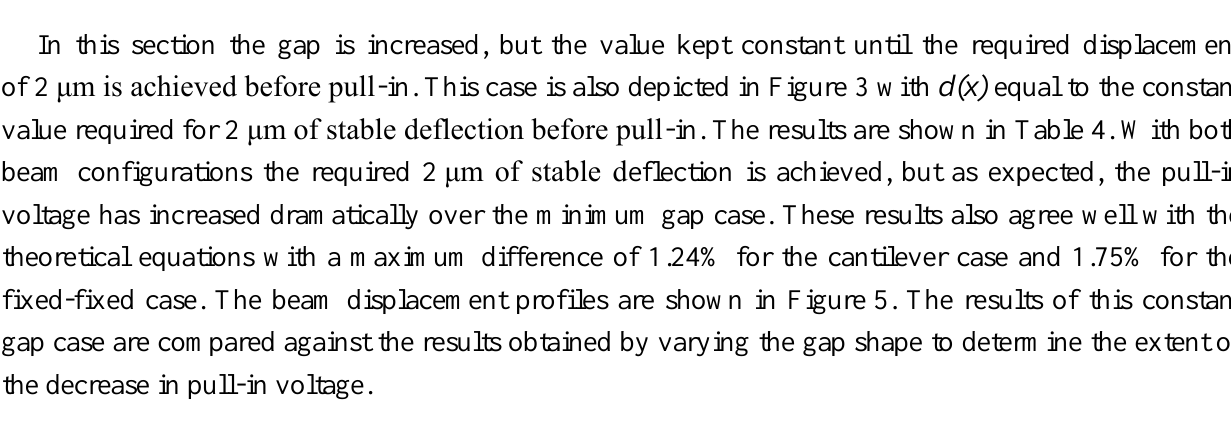
Table 4. Constant gap case results (required 2 μm displacement).